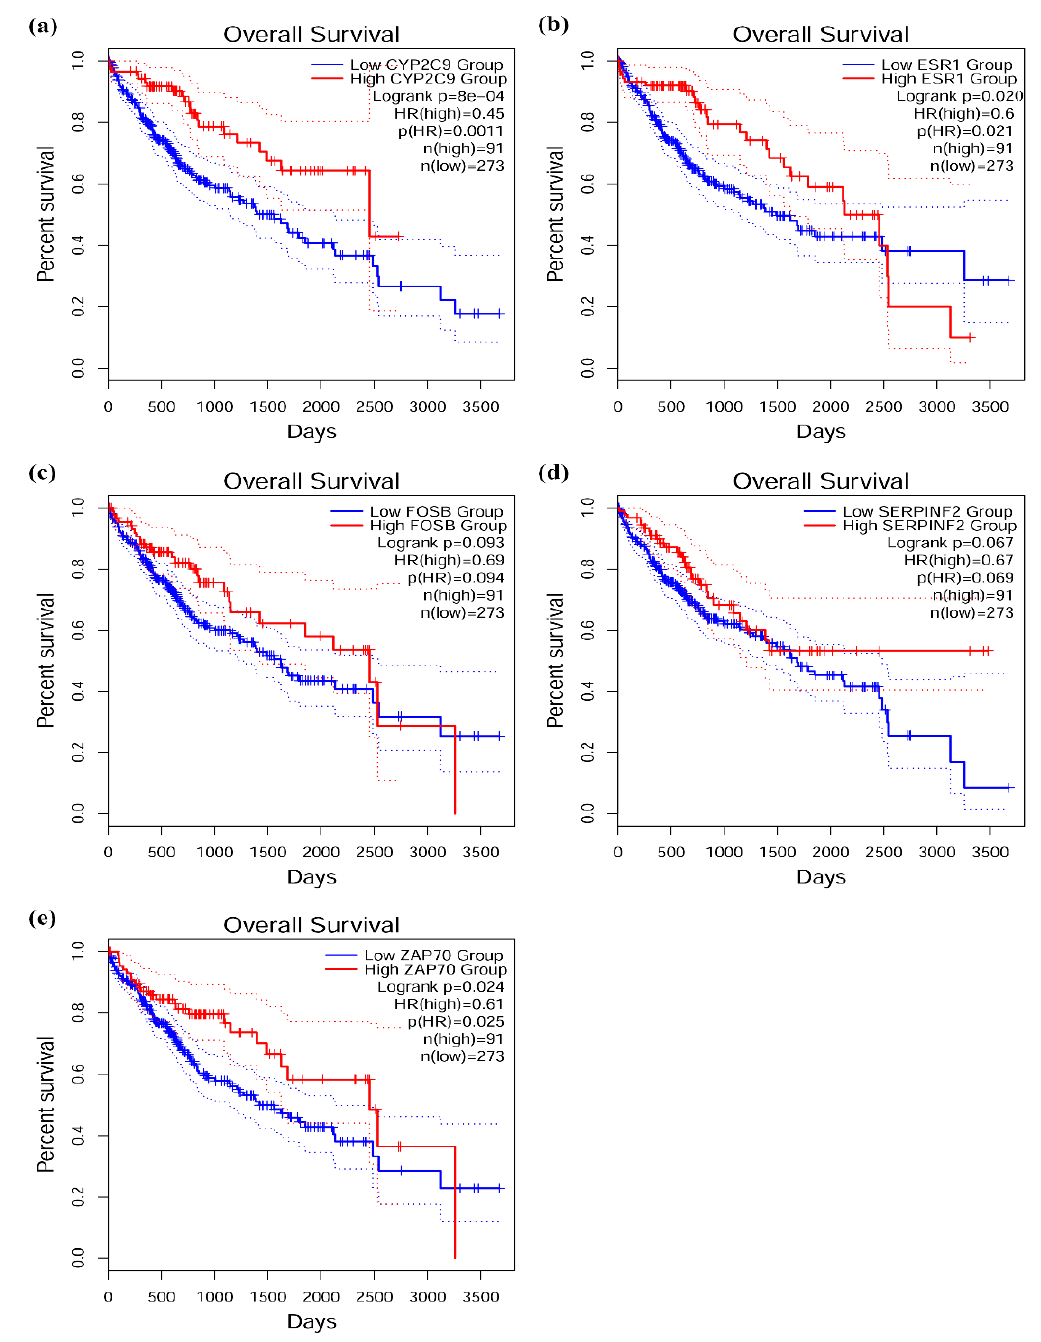
Figure 7. Target genes with significant correlation with survival time in downregulated competing endogenous RNA (ceRNA) network. ( a ) CYP2C9 . ( b ) ESR1 . ( c ) FOSB . ( d ) SERPINF2 . ( e ) ZAP70 . Statistical significance: p -value < 0.1.